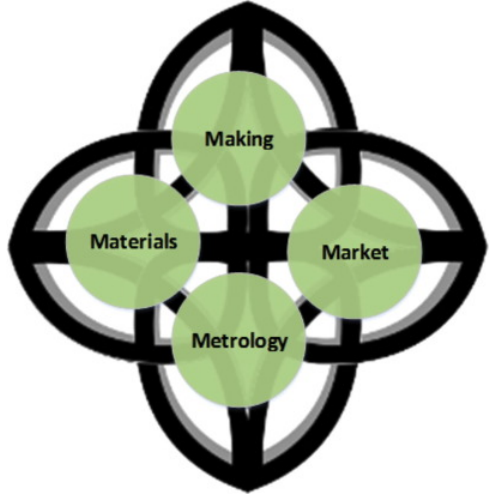
Figure 2: The four M’s of AM